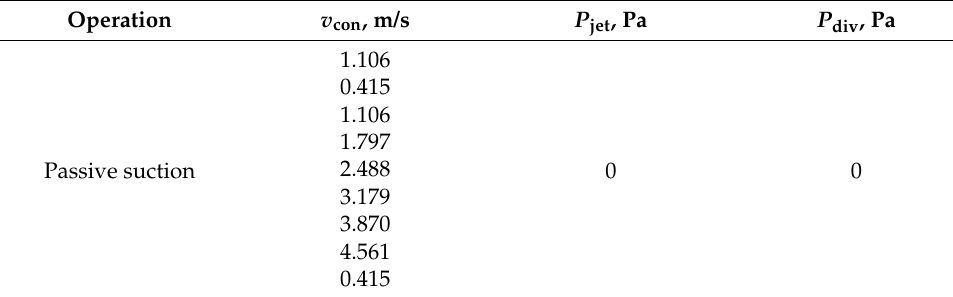
Table 7. The operating conditions in passive suction of VTM.